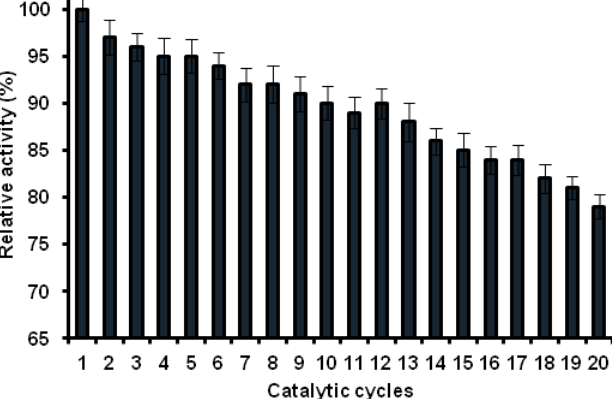
Figure 10. Reuse stability of lipase immobilized on the silica ‐ lignin hybrid matrix.